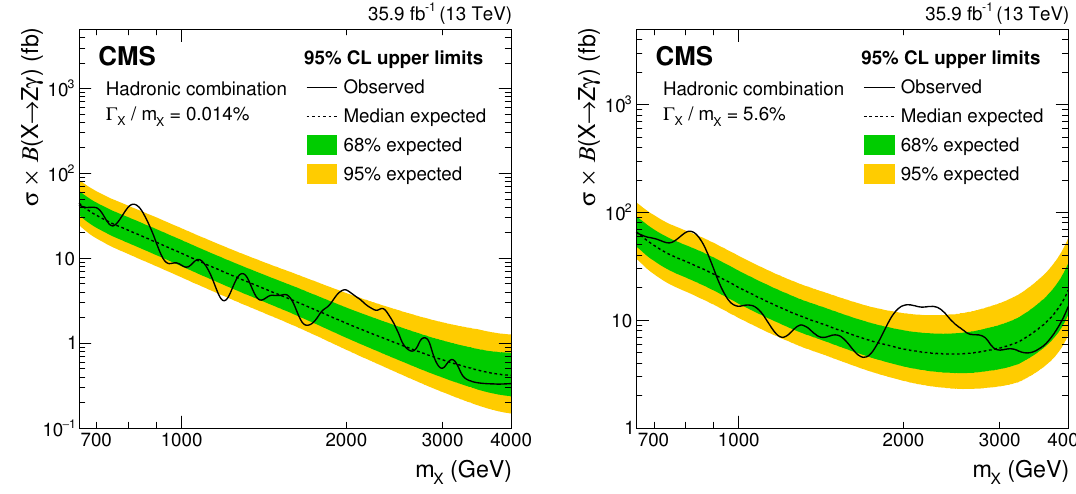
Figure 6 . Observed (solid) and expected (dashed) 95% CL upper limits on (cid:27) (X ! Z (cid:13) ) as a function of signal mass m X , together with the 68% (green) and 95% (yellow) CL ranges of the expected limit for the background-only hypothesis, for the combination of the b-tagged, (cid:28) 21 -tagged, and untagged categories for (left) narrow and (right) broad spin-0 resonances.